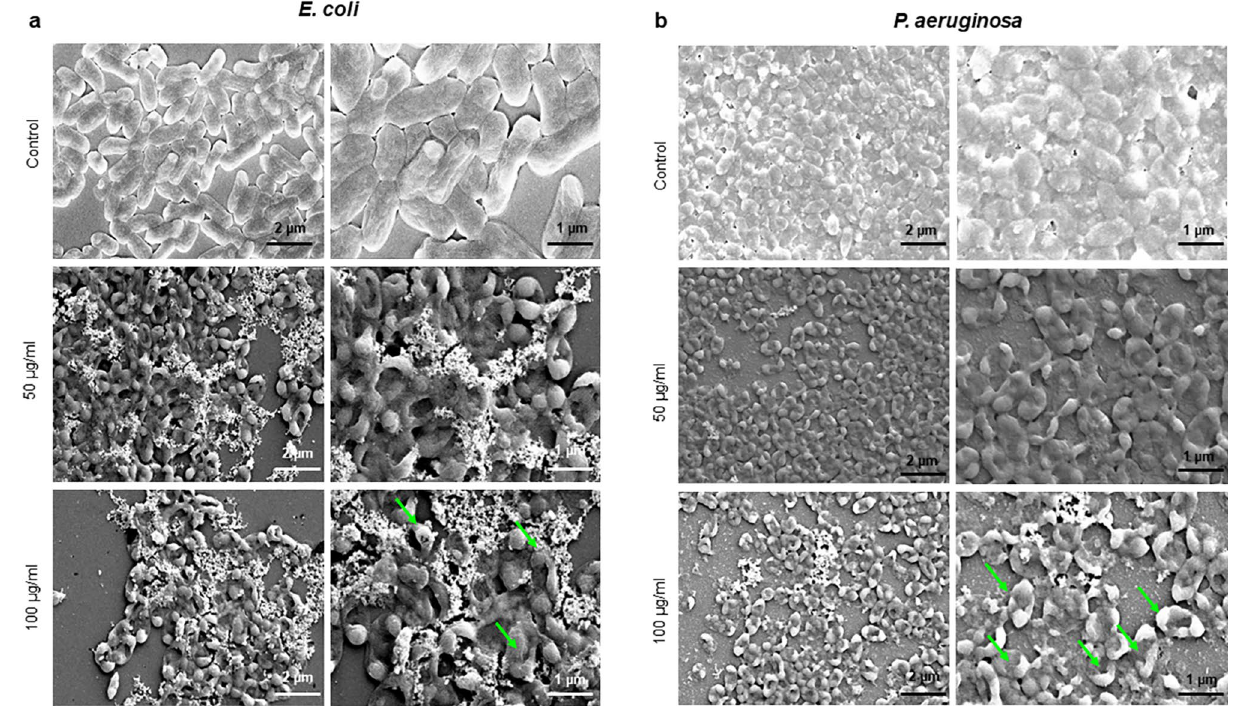
Figure 10. Scanning electron microscopy images of bacteria cells treated with different concentrations of AgNPs, ( a ) E. coli , and ( b ) P. aeruginosa . The green arrows indicate the cell membrane disruption due to the AgNPs